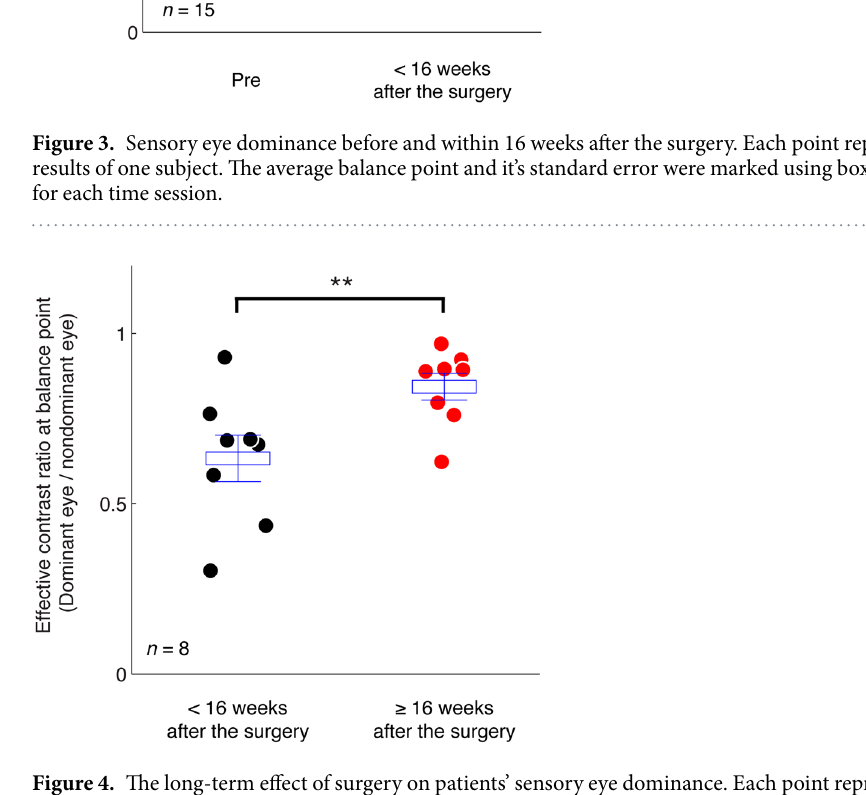
Figure 4. The long-term effect of surgery on patients’ sensory eye dominance. Each point represents the results of one subject. The average balance point and it’s standard error were marked using box and error bars for each time session. Eight patients participated in this study. ** p < 0.01, 2-tailed paired-samples